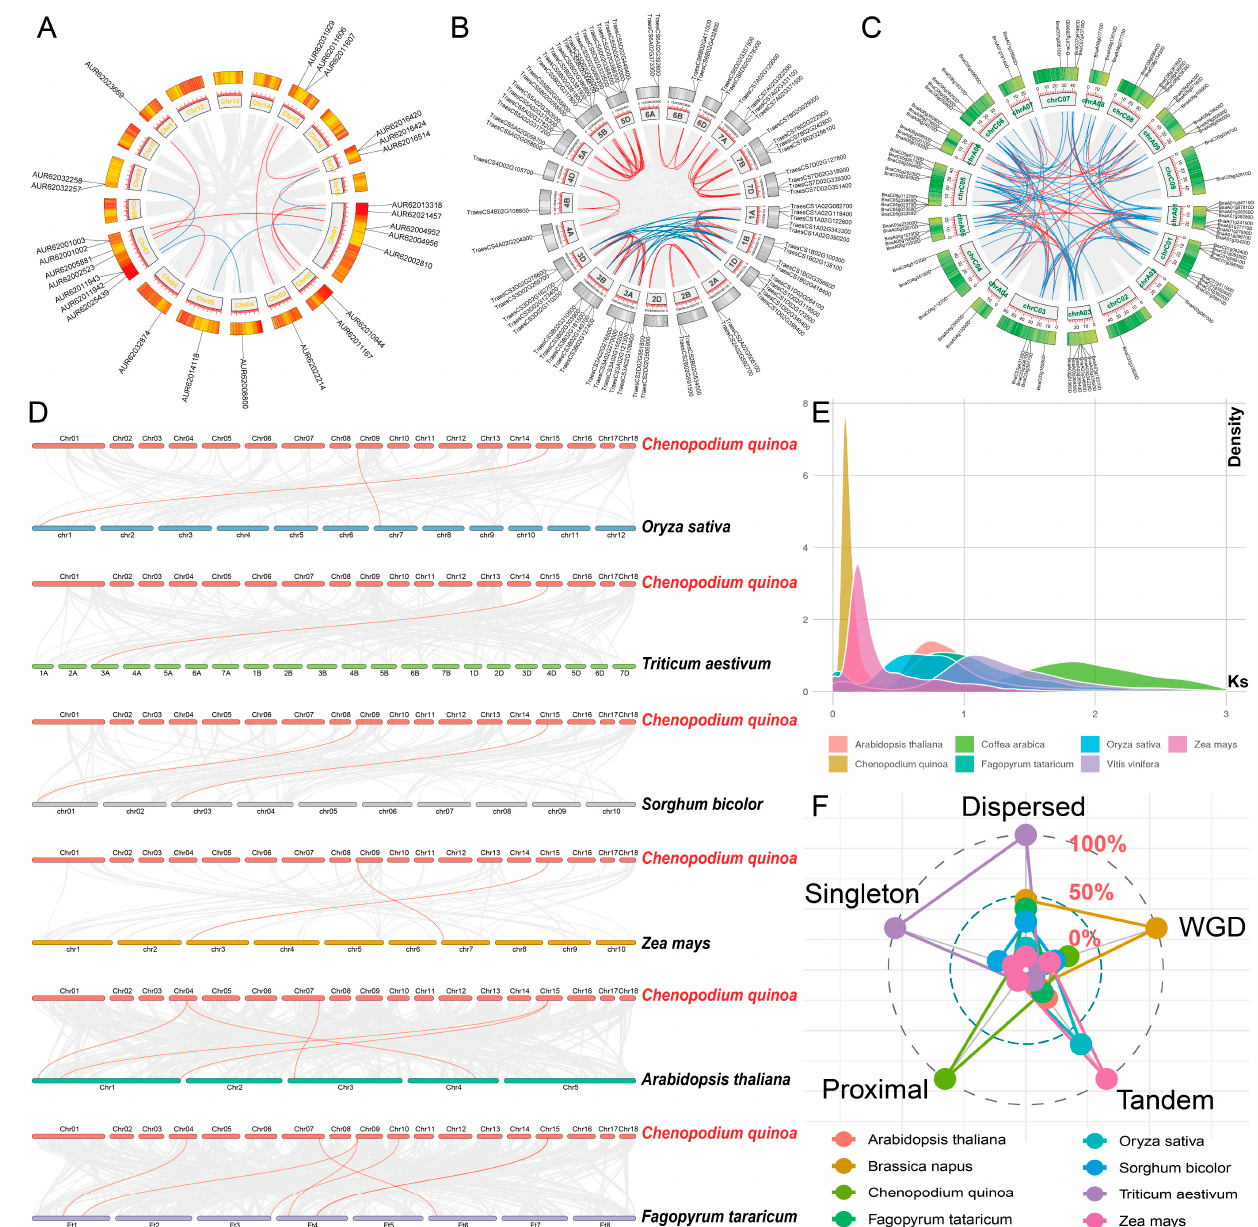
Figure 3. Schematic representations of the interchromosomal relationships of AUX/IAAs , gene duplication types of AUX/IAAs , and WGD events analyses in different species. ( A – C ). Synteny AUX/IAA pairs within the genome of quinoa, wheat, and Brassica napus. The red lines indicate collinear gene pairs from the same subgenome in polyploid species, and the blue lines indicate collinear gene pairs from different subgenome; ( D ). Synteny AUX/IAA pairs between quinoa and other 6 angiospermic genomes; ( E) . The proportion of gene pairs in each plant binned according to Ks values. A high proportion of orthologous gene pairs in plants showed similar rates of synonymous substitutions per synonymous site (Ks), indicative of a whole-genome duplication event; ( F) . Distribution of duplication types of AUX/IAAs in eight multispecies. Multiple collinearity scan toolkit (MCScanX) was used to detect duplication types to identify GRASs associated with ancestral polyploidization events (WGD or segmental). The AUX/IAAs related to polyploidy were inferred according to the collinearity persistence of the region around the selected genes. AUX/IAAs were divided into five groups, including dispersed, proximal, tandem, singleton, and WGD or segmental.